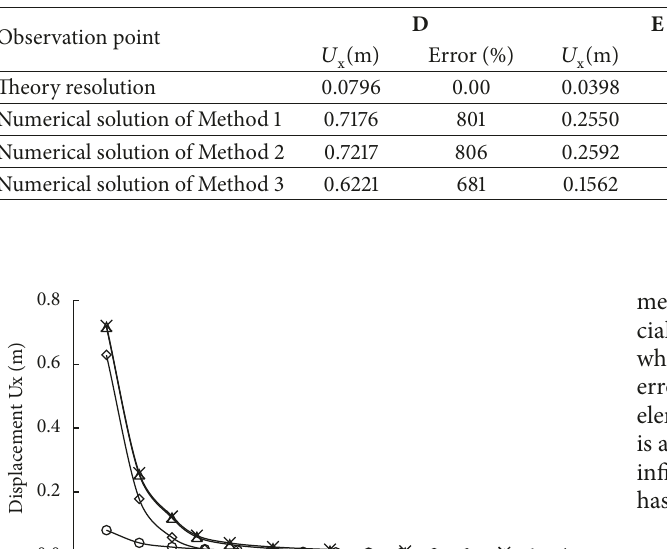
Table 3: Numerical displacements of different boundary methods and their relative errors.